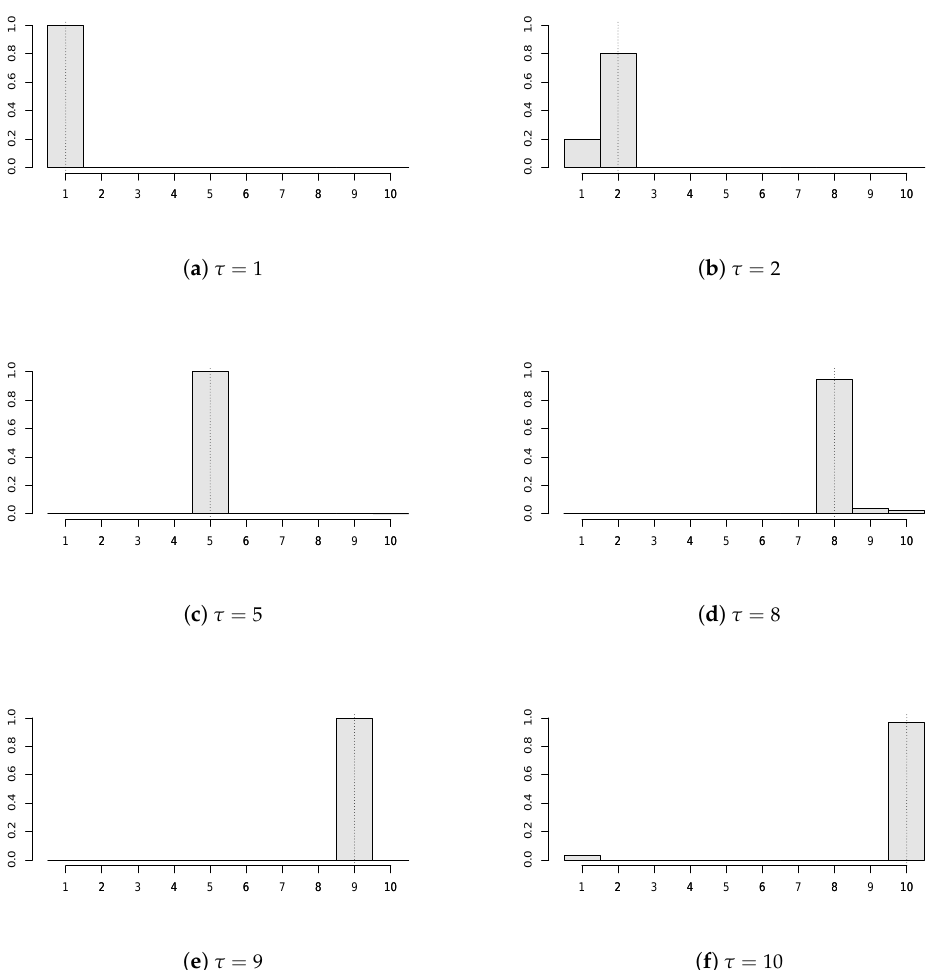
Figure 2. Histograms of the estimated change points (cid:98) τ N for various values of the change point τ ( T = 10, N = 20, σ = 0.2, 75% of the panels are subject to a break of size δ i ∼ U [ 0,2 ] panel disturbances from AR(1) with N ( 0,1 )